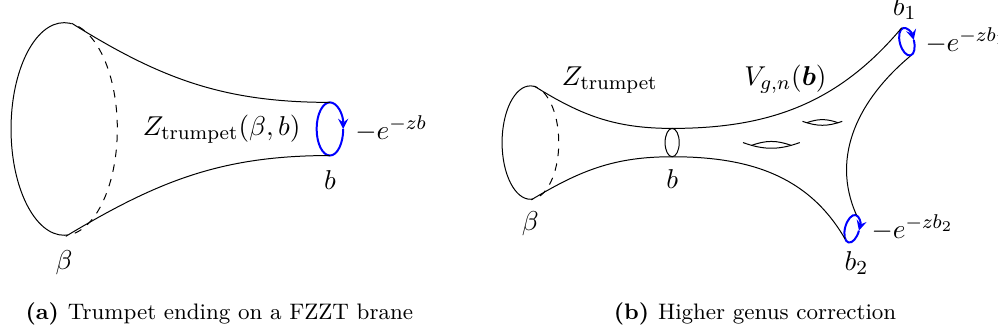
Figure 1. Trumpet can end on a FZZT brane. We attach the factor M ( b ) = − e − zb to the geodesic boundary and integrate over b